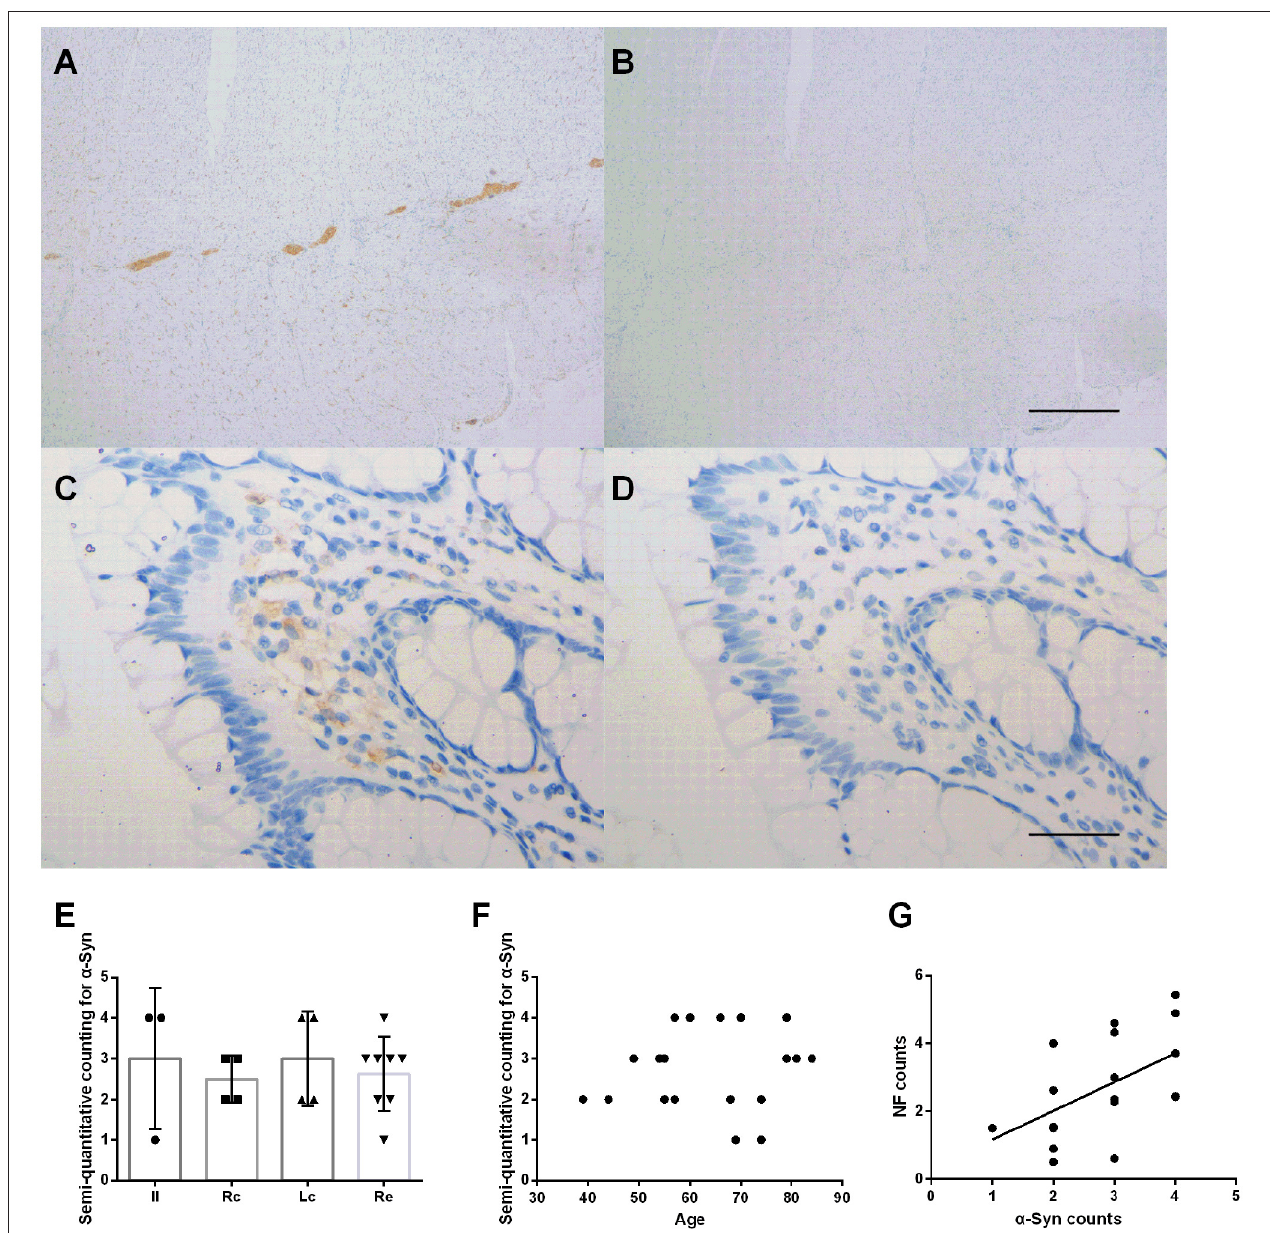
FIGURE 2 | Characteristic of α -Syn immunoreactive signals in the myenteric plexus. (A–D) . Representative image of immunostaining for α -Syn in the myenteric plexus. α -Syn immunoreactive signals (brown color) in the myenteric plexus (A) , and the mucosa (C) . (B,D) Are negative controls. Hematoxylin counterstain, scale bars = 500 µ m (A,B) , 50 µ m (C,D) . (E) Specimens were subdivided into the ileum (Il), right colon (Rc), left colon (Lc), and rectum (Re). Semi-quantitative analysis of α -Syn immunoreactive signals among the groups in the myenteric plexus (Kruskal–Wallis test, p = 0.812). Data shown as mean ± SD. (F) Scatter plot of the